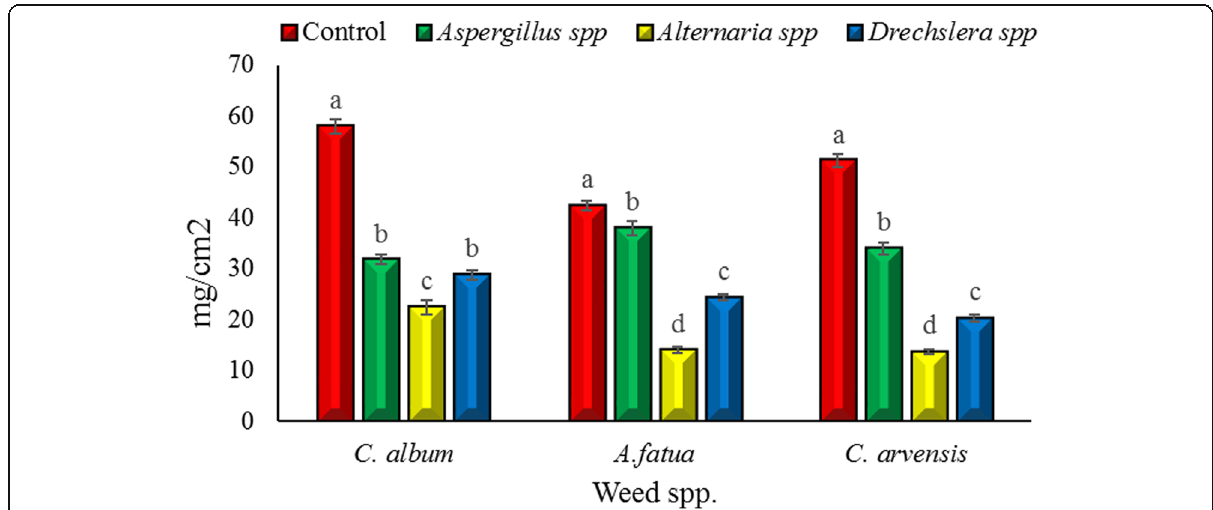
Fig. 4 Effect of cultural filtrates of endophytic fungi on the chlorophyll (mg/cm 2 ) of C. album , A. fatua , and C. arvensi s. Different letters